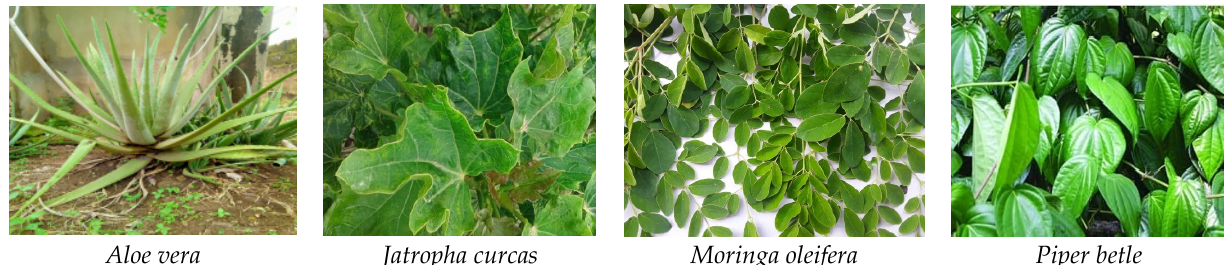
Figure 2. Plant leaves from which the crude plant extracts collected.